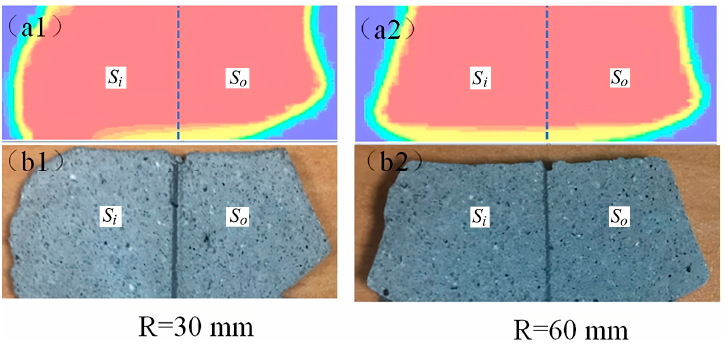
Figure 3. Numerical simulation and experimental results of the cross-section of the printed filament at corners, with ( a ) simulation results and ( b ) experimental results [8].